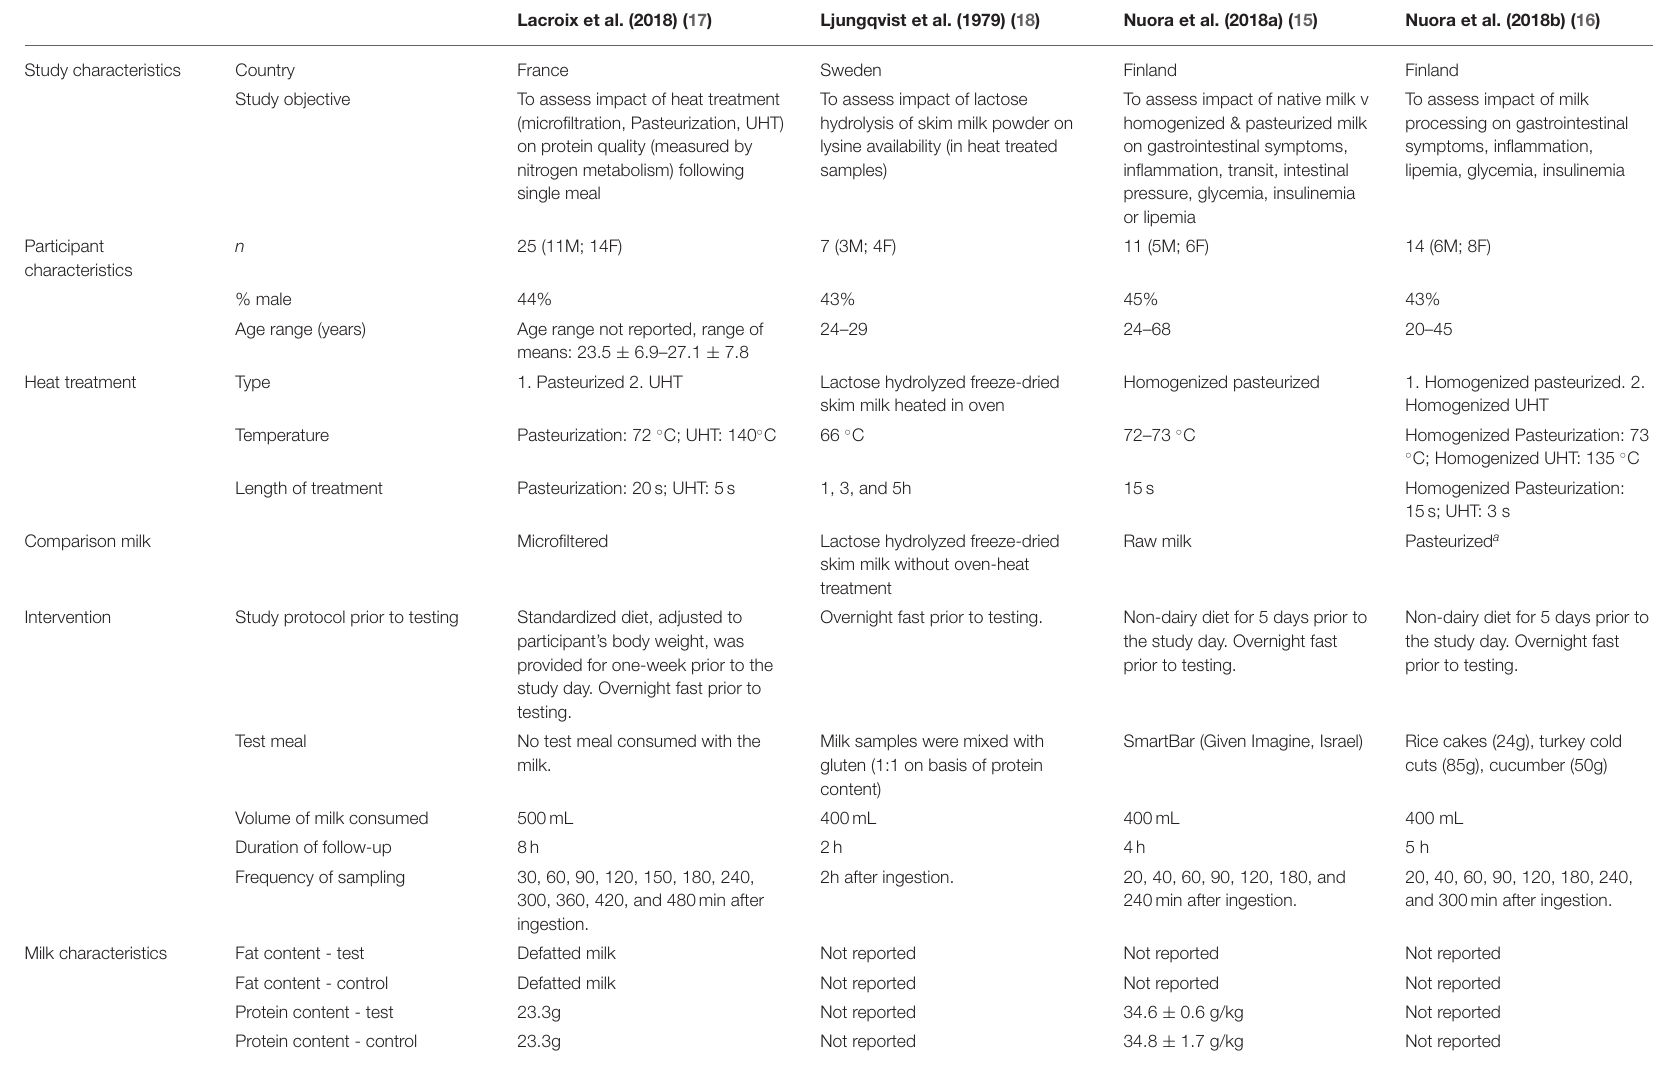
TABLE 3 | Characteristics of included studies assessing postprandial protein or lipid responses to heat treated milk in